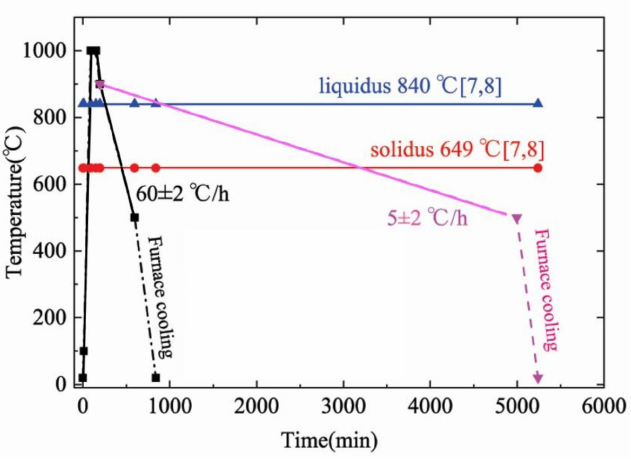
Figure 1. SchemeofheattreatmentofAl-30wt.%Er, coolingrateof60 ± 2 ◦ C/hand5 ± 2 ◦ C/h,